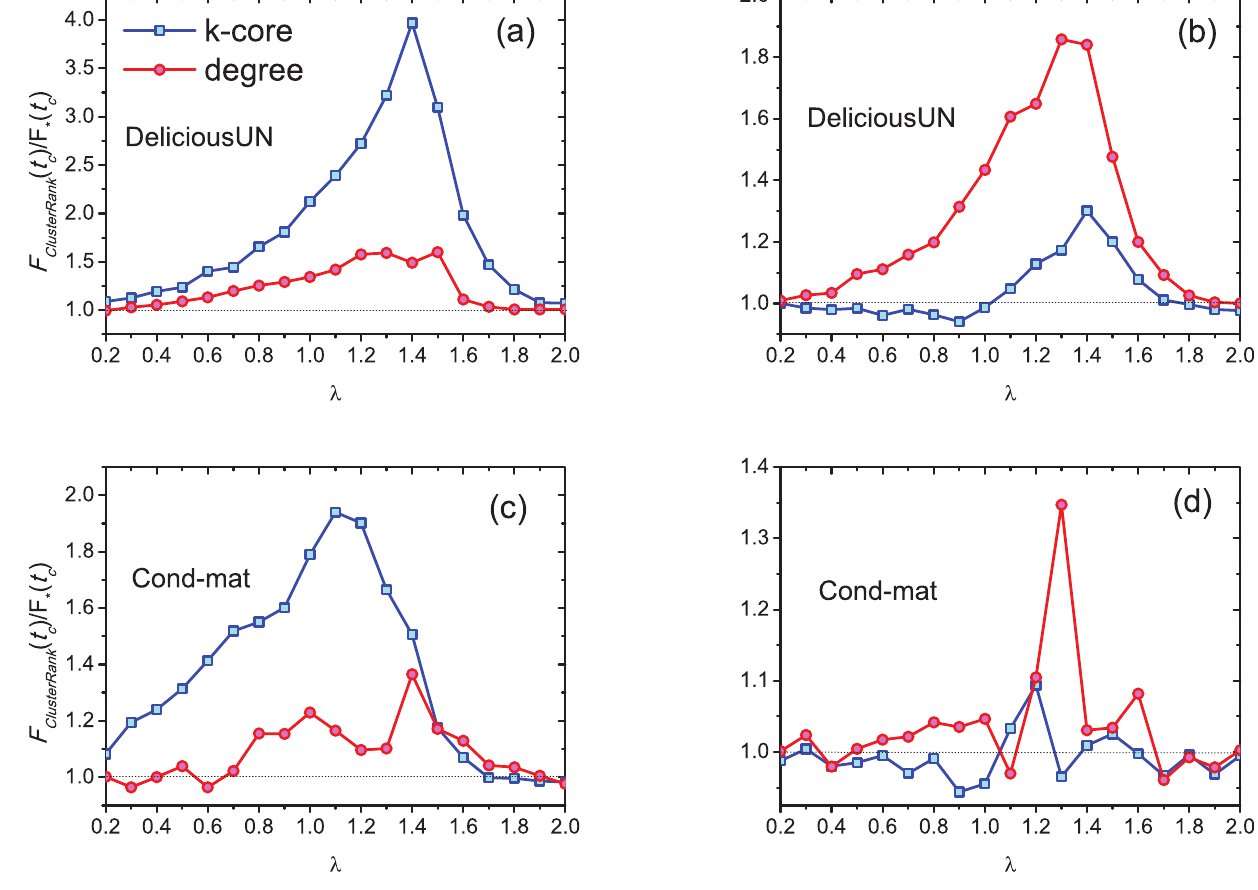
Figure 8. The dependance of F ClusterRank ( t c ) = F (cid:2) ( t c ) on parameter l in undirected Delicious and Cond-mat networks. We set b ~ 1 = S k T . In (a) and (c), the initial infected nodes are those non-overlapped nodes in the top-50 places regardless of whether they are connected or not. In (b) and (d), the initial infected nodes are the non-overlapped nodes in top-50 places under constraint that any two of them are not connected. Each data point is obtained by averaging over 100 independent runs.